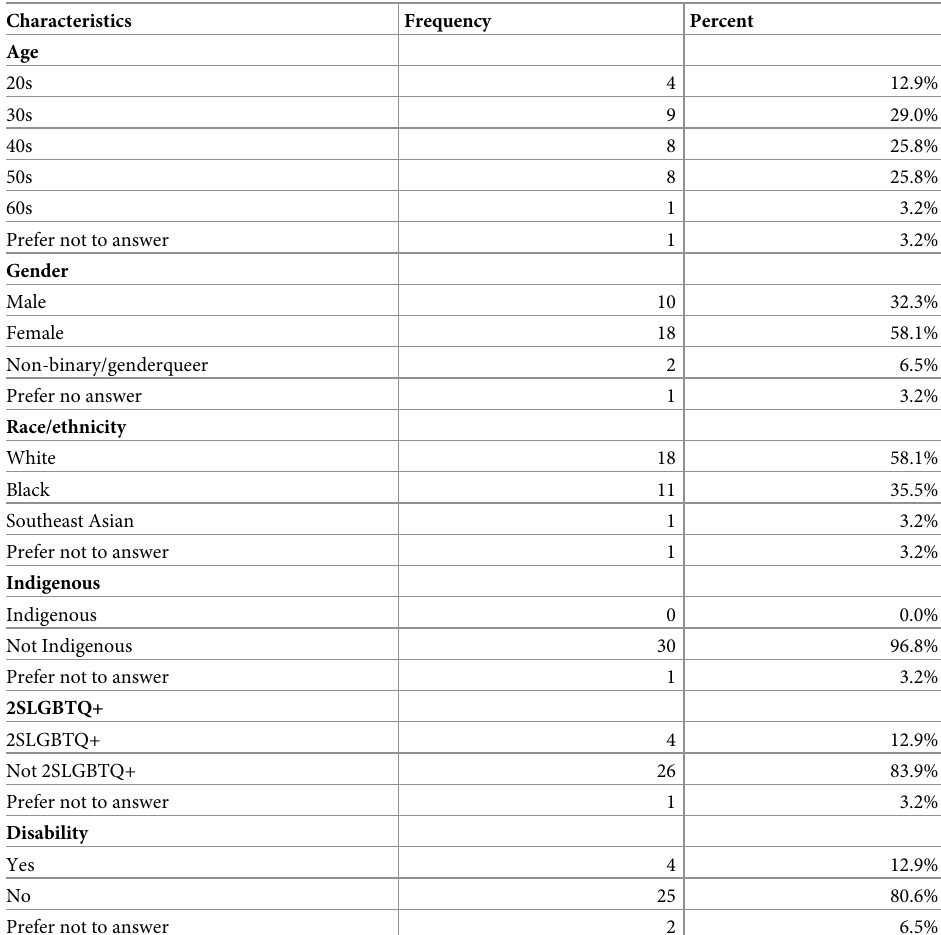
Table 2. Staff participant